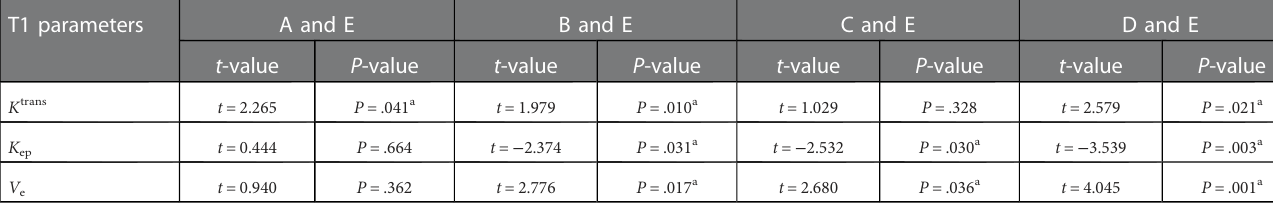
TABLE 4 Results of pairwise comparisons between healthy femoral heads and different areas of necrotic ones, respectively (independent samples T test). T1